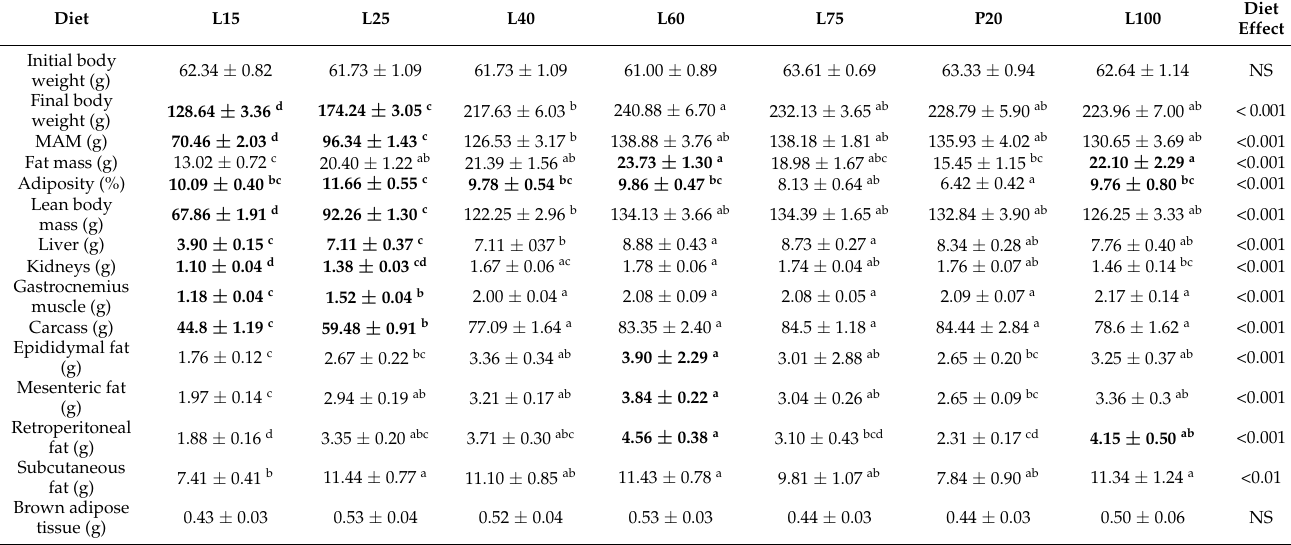
Table 3. Absolute and relative values of body composition for lysine